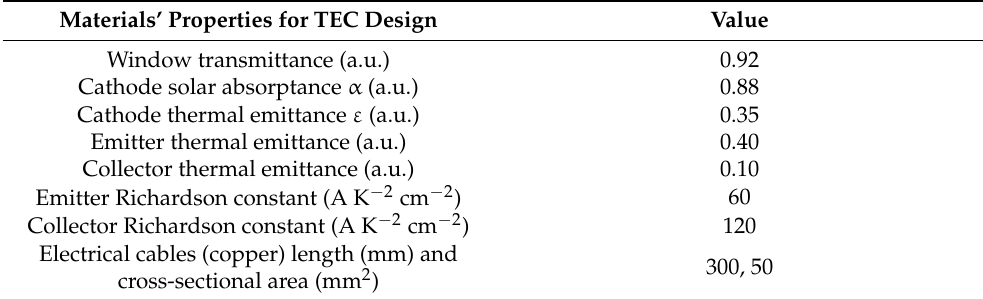
Table 3. Main properties of the materials involved in the evaluation of the TEC performance. Materials’ Properties for TEC Design Value Window transmittance (a.u.) 0.92 Cathode solar absorptance α (a.u.) 0.88 Cathode thermal emittance ε (a.u.) 0.35 Emitter thermal emittance (a.u.) 0.40 Collector thermal emittance (a.u.)